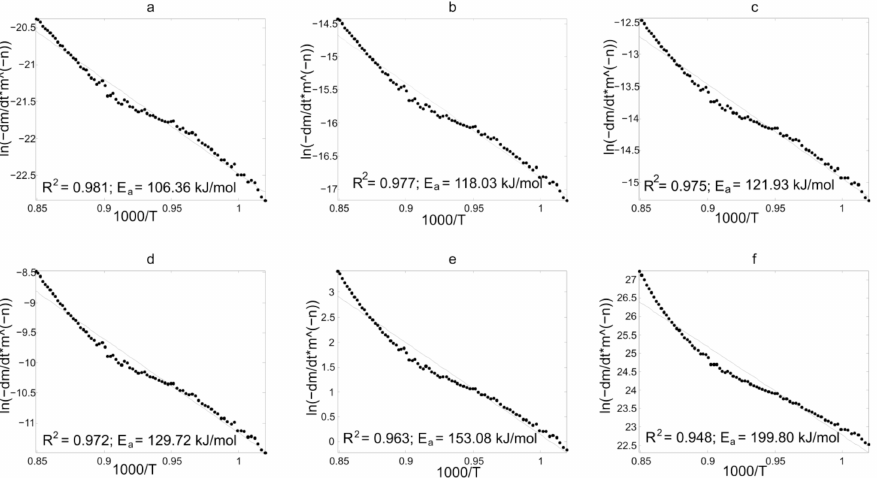
Figure 5. The results of processing of the TG curve of charcoal gasification at a heating rate of 10 K min − 1 using Equation (2) with different exponents: ( a ) n = 0; ( b ) n = 1; ( c ) n = 2/3; ( d ) n = 0.5; ( e ) n = 2; ( f ) n = 4.